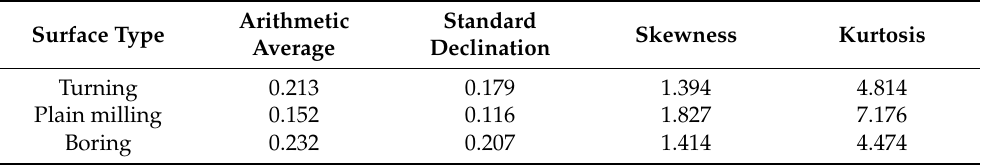
Table 2. Distribution characteristic index of the normal declination angle of Ra 3.2 μ m sample surface topography.